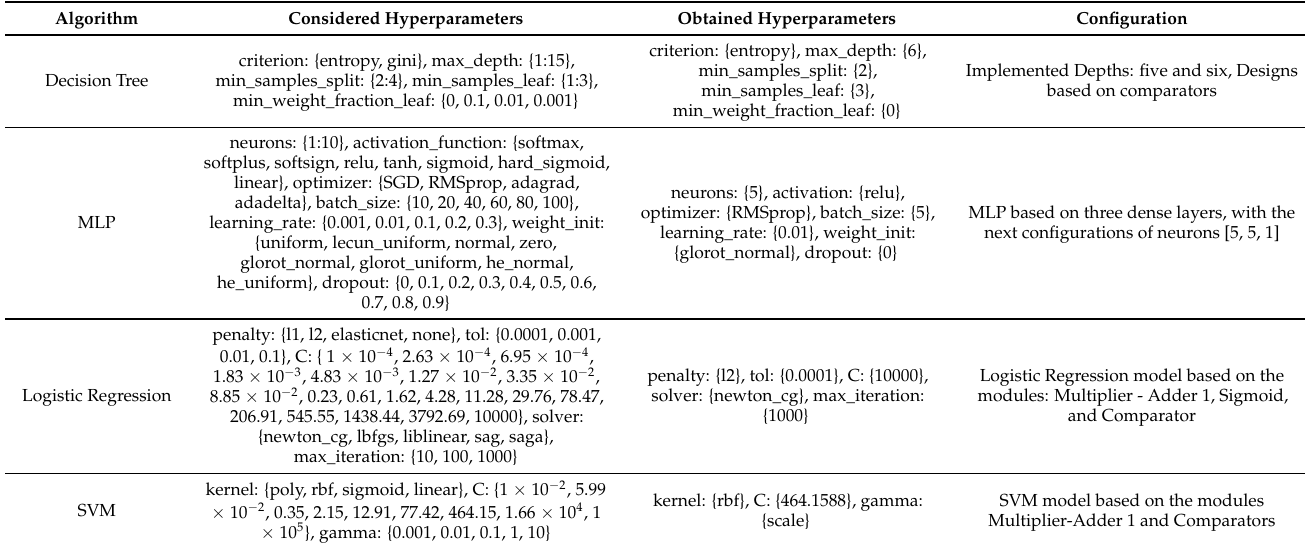
Table 2. Hyper-parameters Used for the Developed Machine Learning Algorithms. Obtained Hyperparameters